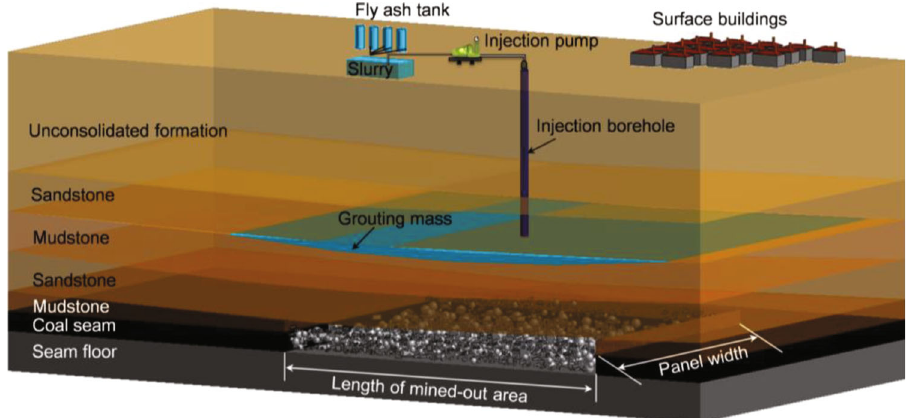
Figure 3: Diagram of partial overburden grouting mining